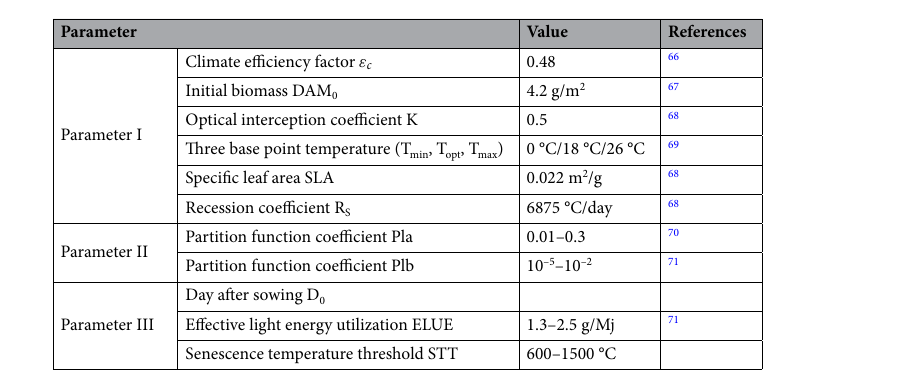
Table 3. Main parameter settings for the SAFY